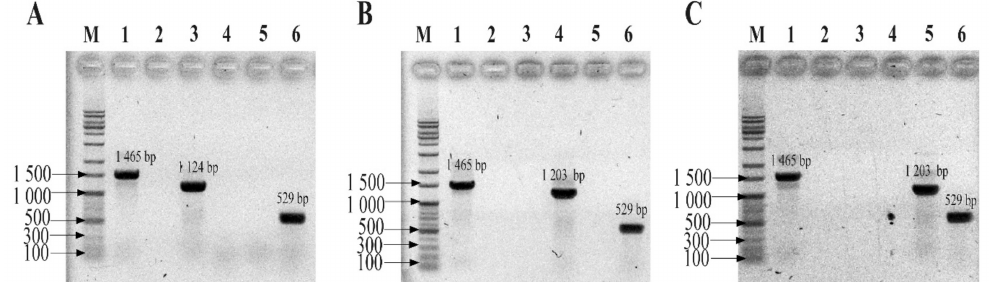
Figure 1. Agarose gel electrophoresis of singleplex PCR products produced by phylum-specific probes for ( A ) Bacteroides fragilis GUT-04, ( B ) Clostridium butyricum TO-A, and ( C ) Shigella sonnei KCCM 41282.